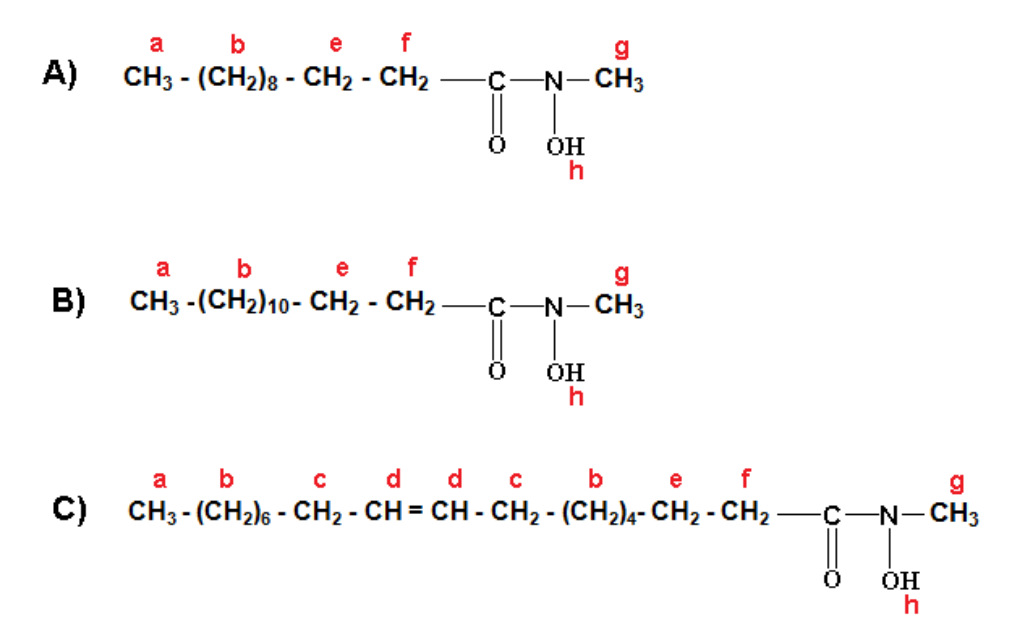
Figure 3. Formulation of methyl laureohydroxamic acid (A); methyl myristohydroxamic acid (B); methyl oleohydroxamic acid